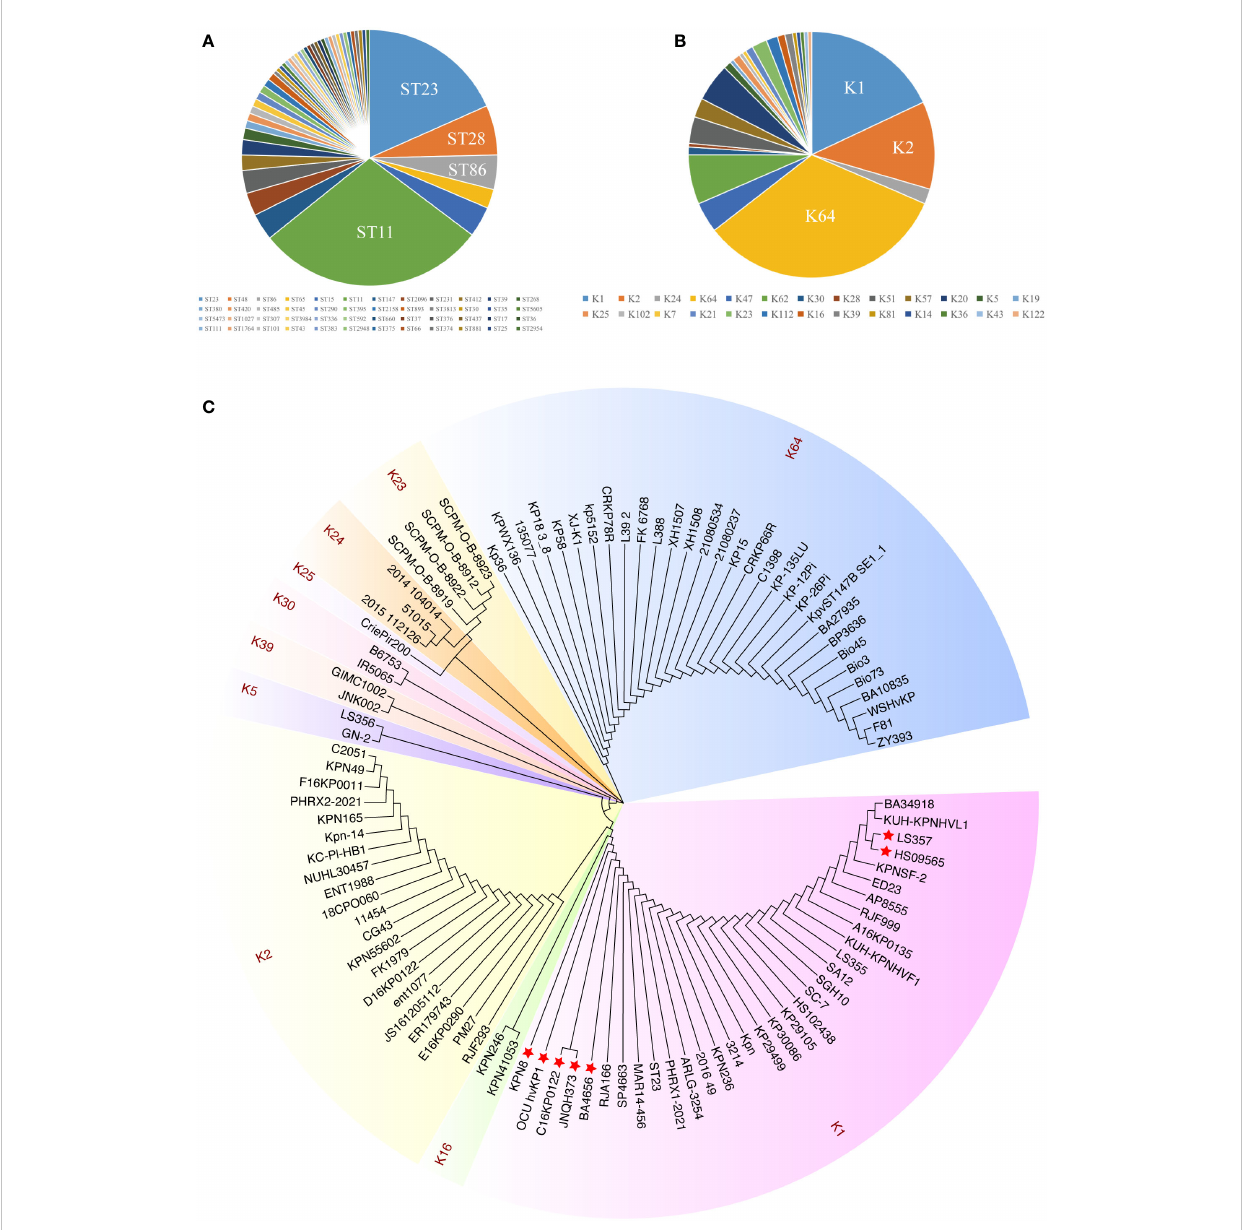
FIGURE 1 The distribution and sequence diversity of wcaJ/wbaP among hvKp strains. (A) MLST of the 226 completely sequenced hvKp strains available from GenBank. (B) The serotypes of the 226 hvKp strains available from GenBank. (C) A Klebsiella pneumoniae phylogenetic tree of wcaJ sequences in various K. pneumoniae serotypes. The tree was constructed using the maximum likelihood method with 1,000 bootstrap replicates in the MEGA7 software package. Different colors represent different serotypes. The strains marked with red star refer to nucleotide mutations in its wcaJ